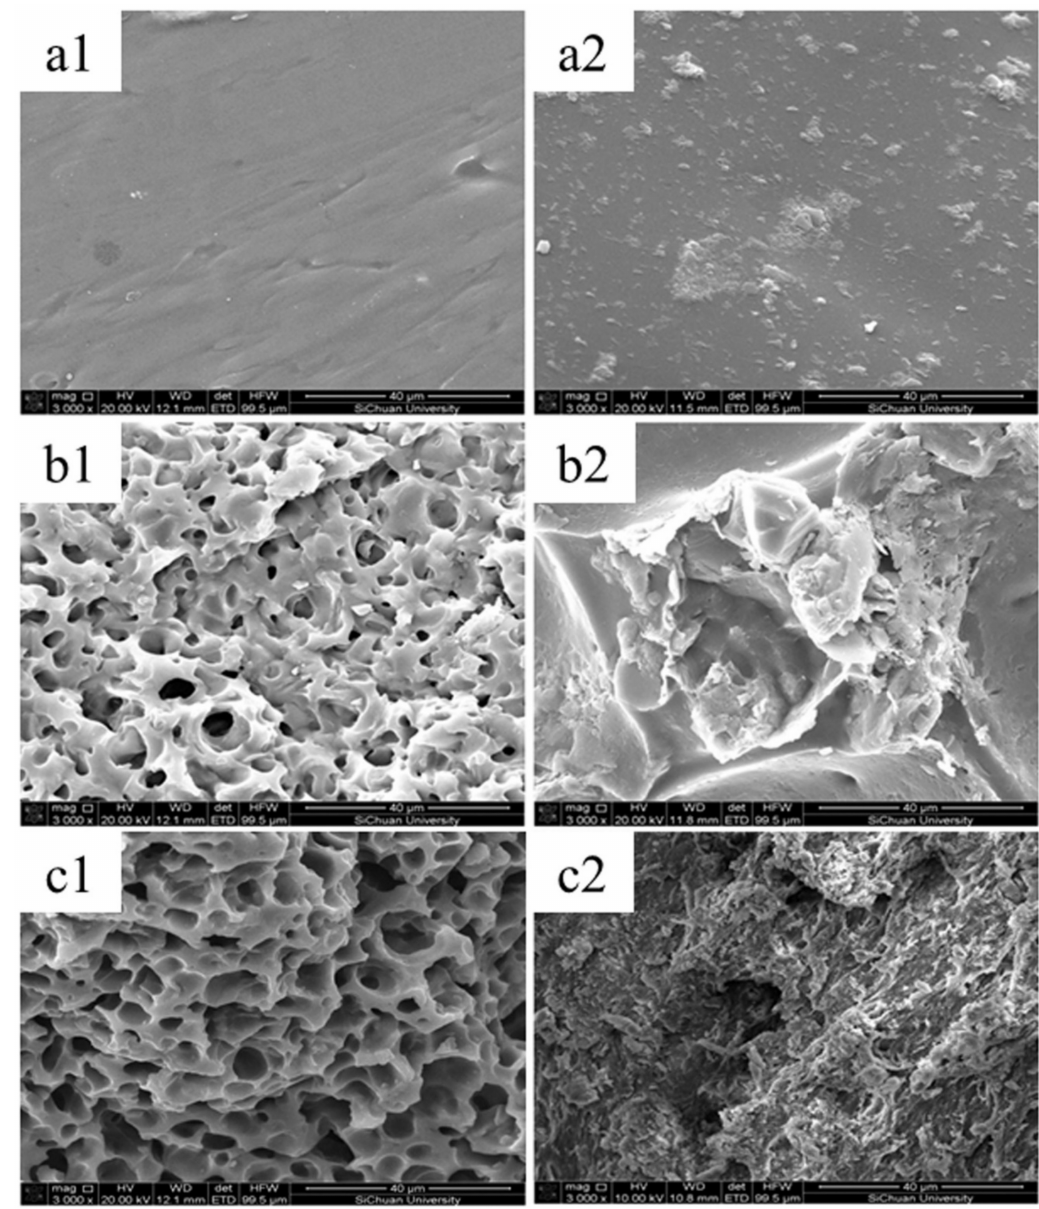
Figure 6. SEM images of control ( a ) and collagen-based fertilizer ( b,c ) samples before ( 1 ) and after ( 2 ) degradation in soils ( a,b ) and in Ensifer sp. Y1 medium ( c ). Reprinted with permission from ref. [33]. 2022,